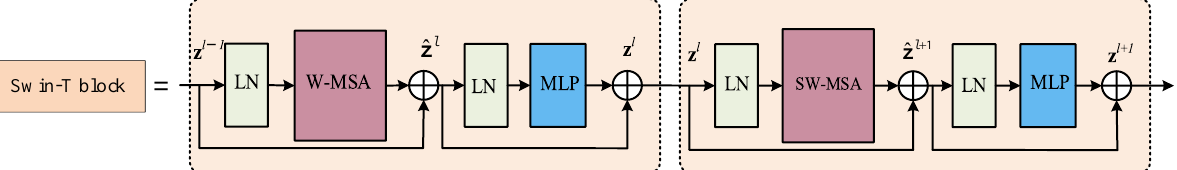
Figure 6. Swin Transformer block.